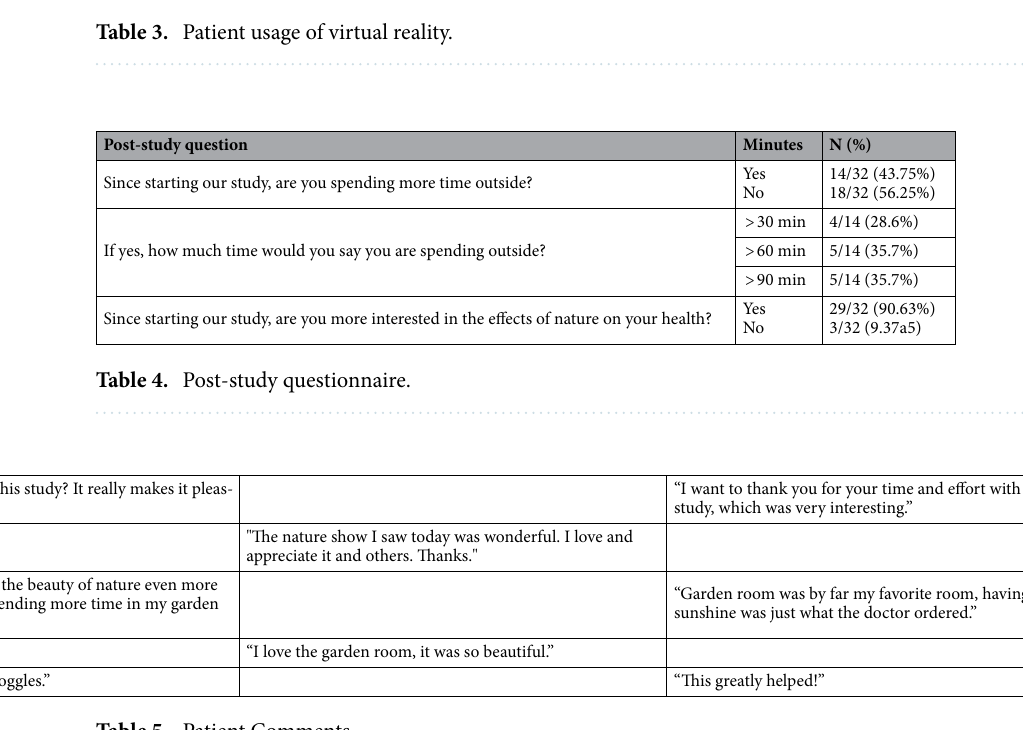
Table 5. Patient